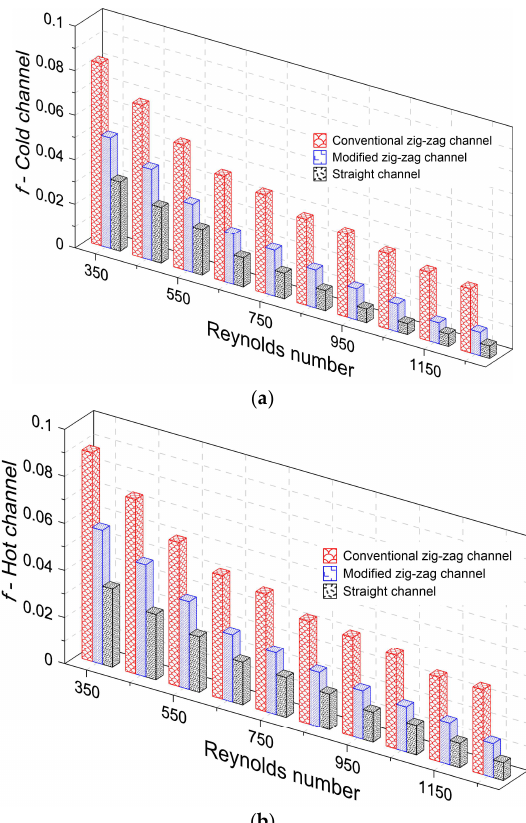
Figure 8. Friction factor for the different channel configurations: ( a ) cold channel; ( b ) hot channel. The results indicate a slight variation in the behavior of the friction factor for the hot and cold channels. In general, the friction factor increased 4.4 and 1.8 times in the conventional zig-zag channel and modified zig-zag channel compared to that of the straight channel. On the other hand, Figure 9 shows the behavior of the Nusselt number (Nu) in relation to the Reynolds number